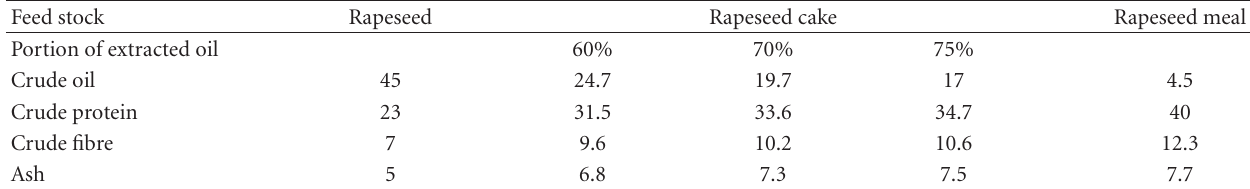
Table 4: Composition of rapeseed, rapeseed cake after extraction of 60, 70, and 75% of oil and rapeseed meal, in percents of total solids [111]. Feed stock